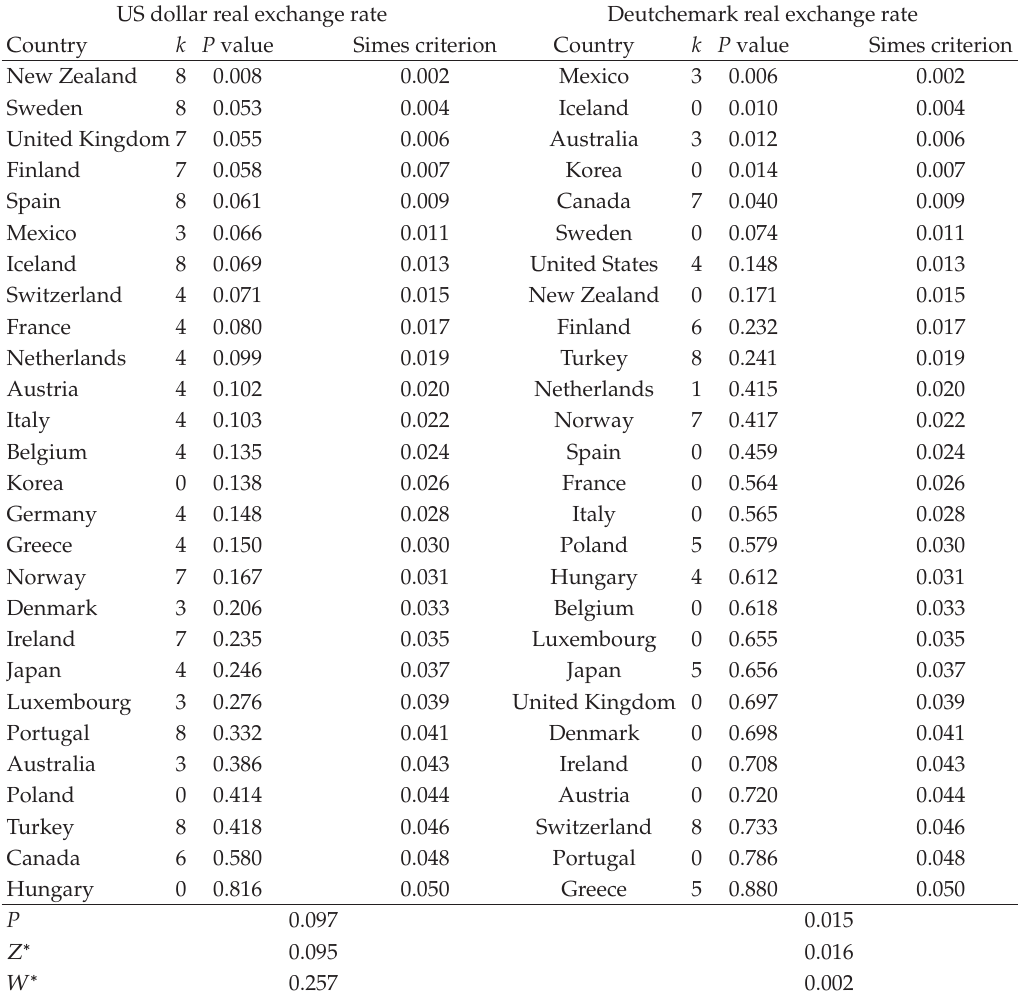
Table 8: Unit root tests for 27 OECD real exchange